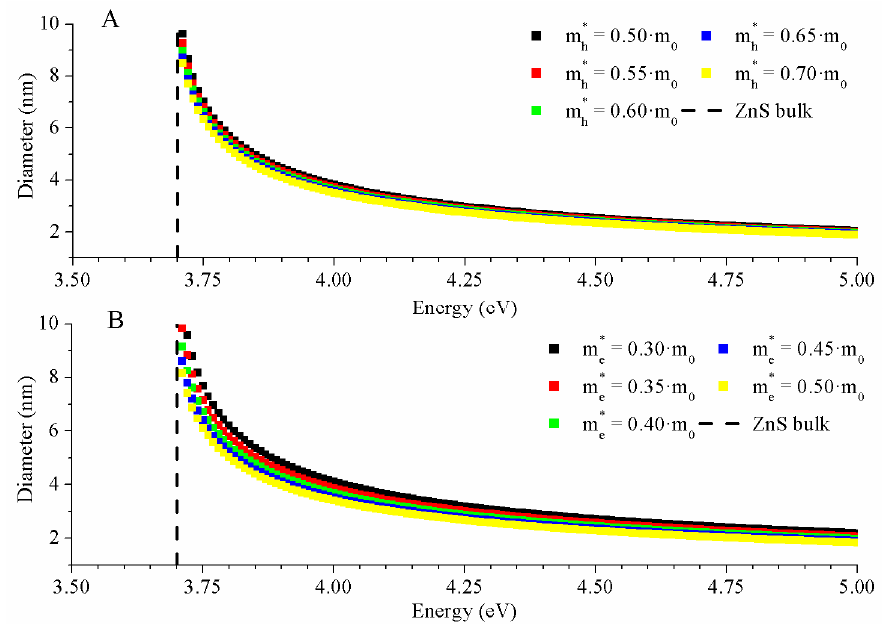
Figure 8. The m h * variation study ( A ) for Brus equation of ZnS nanoparticles for di ff erent energies, from high values of energy to ZnS energy bulk. The m h * oscillated between m h * = 0.50 · m o and m h * = 0.70 · m o and with the rest of the variables remaining constant: E b = 3.70 eV, ε = 8.76, and m e * = 0.42 · m o . The m e * simulation ( B ) for Brus equation of ZnS nanoparticles for di ff erent energies, from high values of energy to ZnS energy bulk. The m e * oscillated between m e * = 0.30 · m o and m e * = 0.50 · m o and with the rest of the variables remaining constant: E b = 3.70 eV, ε = 8.76, and m h * = 0.61 · m o